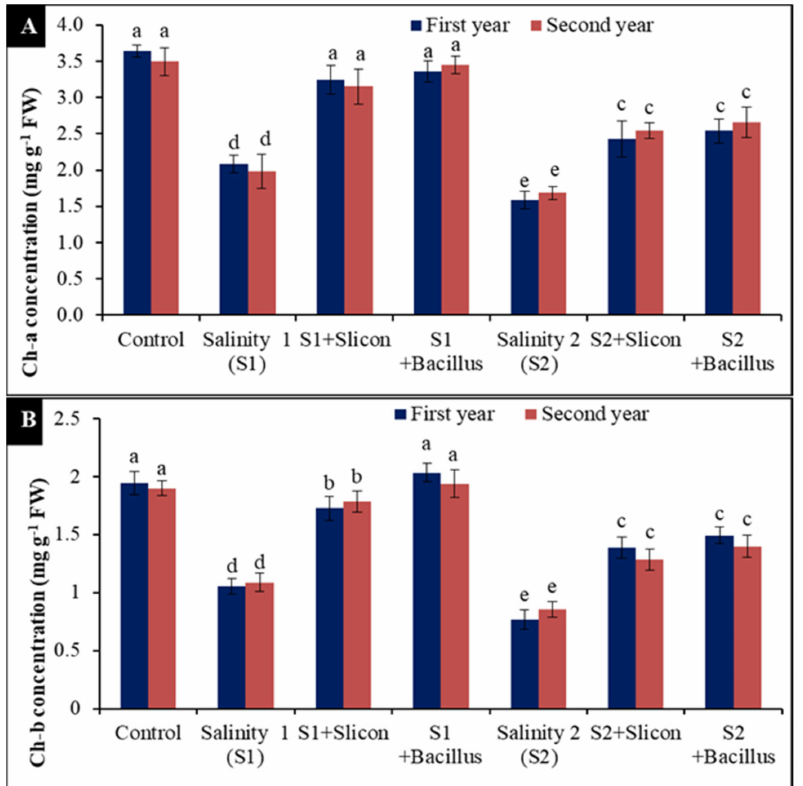
Figure 5. Effect of Si (potassium silicate at 2.7 mmol L − 1 ) and B. thuringiensis on chlorophyll a ( A ) and chlorophyll b ( B ) in lettuce plants under salinity during two seasons (2019/2020 and 2020/2021). Different letters on the columns show significant differences between the treatments according to ANOVA, Duncan’s multiple range test at 0.05 level. Data is the mean ( ± SE) of tree replicates. Salinity 1 (S1): 4 dS m − 1 , Salinity 2 (S2): 8 dS m − 1